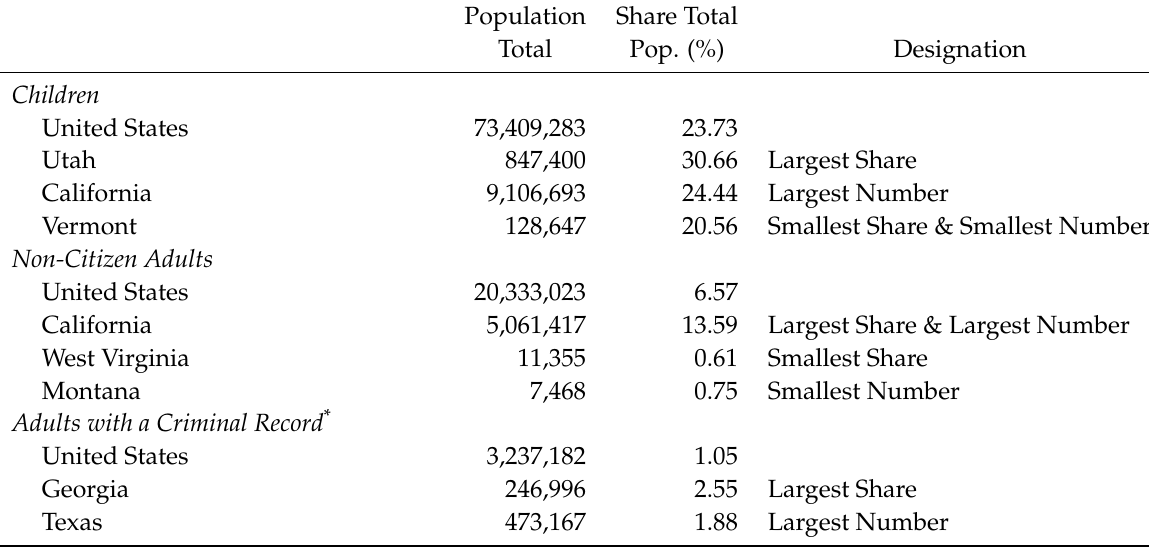
Table 1: Sources of Non-enfranchisement in the United States,